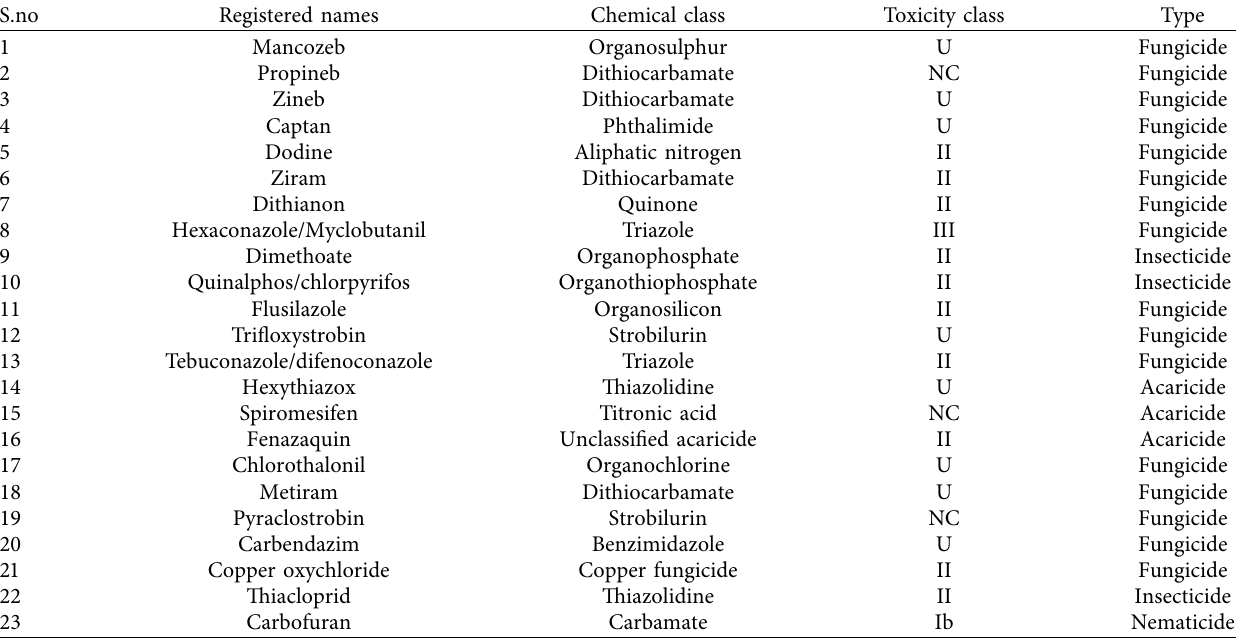
Table 1: Commonly used pesticides in south Kashmir and their toxicological class recommended by